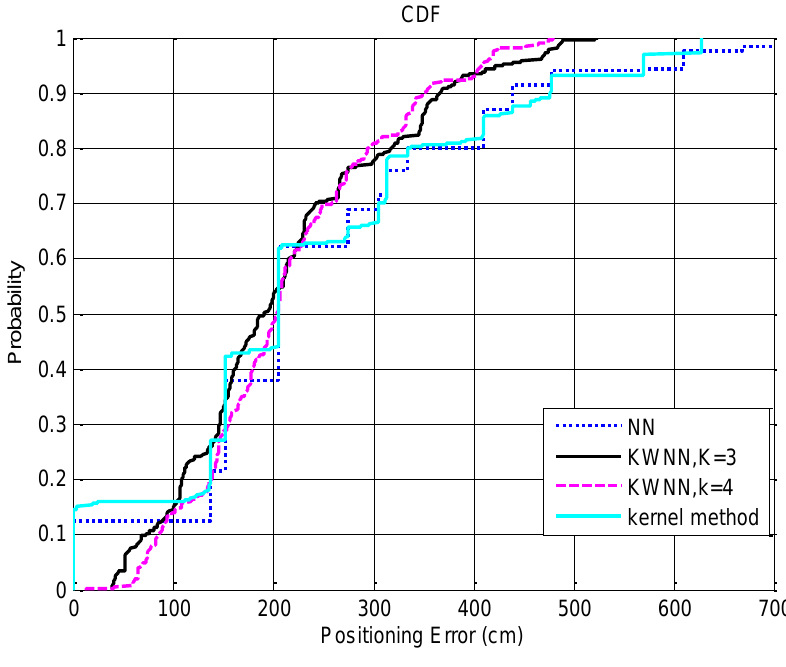
Figure 12. The CDFs of the positioning errors by various matching algorithms.